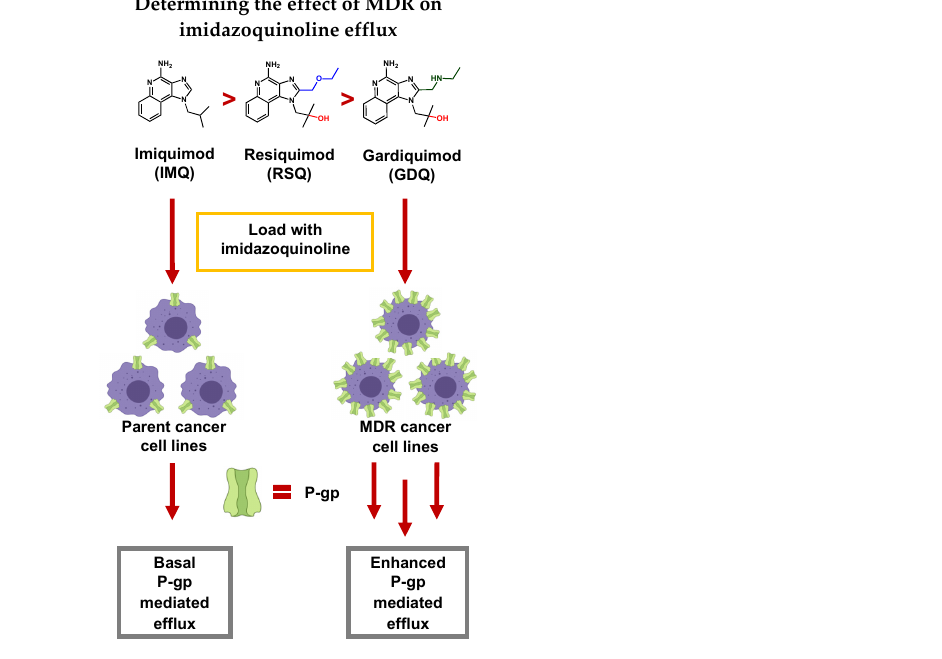
Figure 1. In this study we establish that Imiquimod (IMQ), Resiquimod (RSQ), and Gardiquimod (GDQ) are substrates of P-gp, and compare P-gp-mediated efflux between Multidrug-Resistant (MDR) cancer cell lines relative to parent cell lines. We also conclude that some efflux likely occurs through other transport proteins as well as passive transport into the extracellular space.